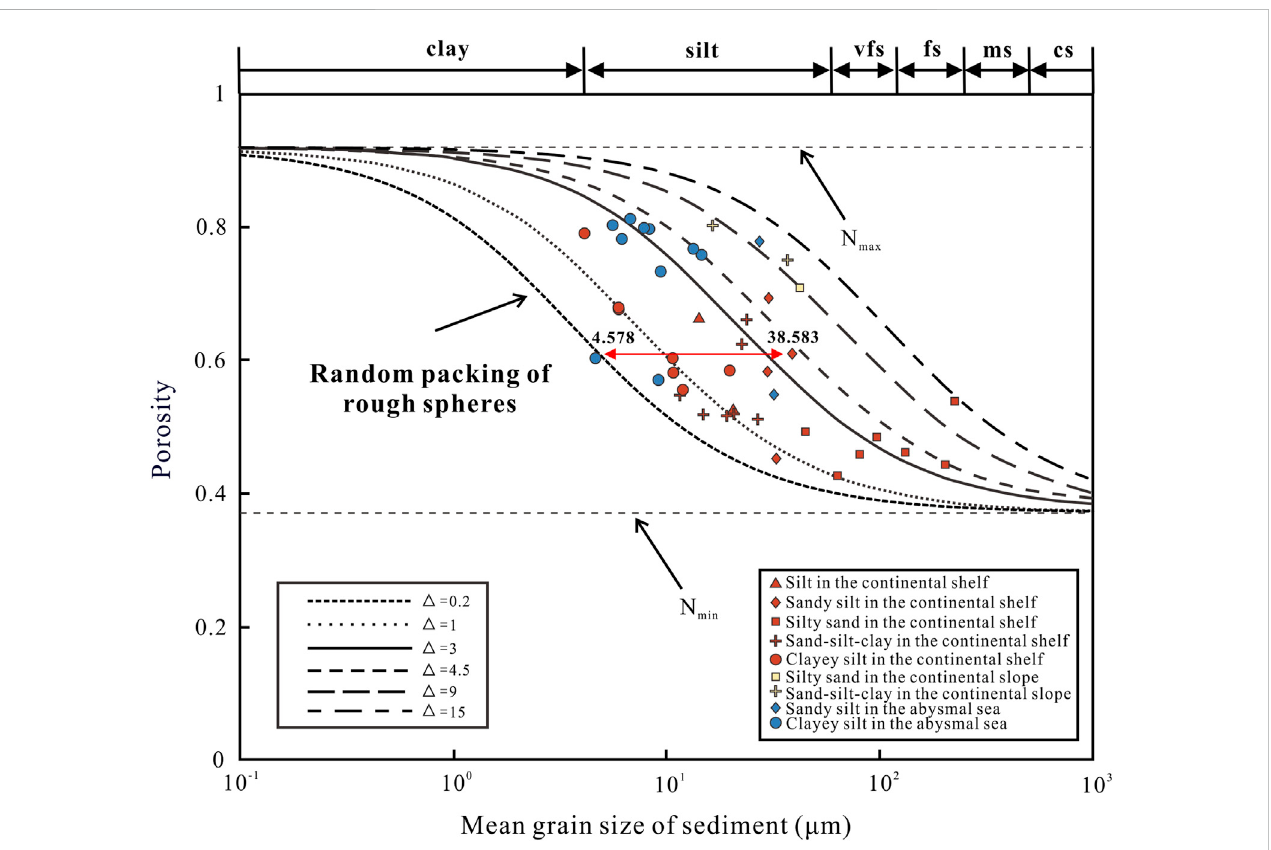
FIGURE 2 Relationshipbetweenthemeangrainsizeandporosityofsea fl oorsediments.Thelinerepresentsthemeangrainsizeversusporosityanddensitycurveof RMS (root mean square) roughness = 0.2, 1, 3, 4.5, 9, and 15 μ m vfs is very fi ne sand; fs is fi ne sand; ms is medium sand; and cs is coarse